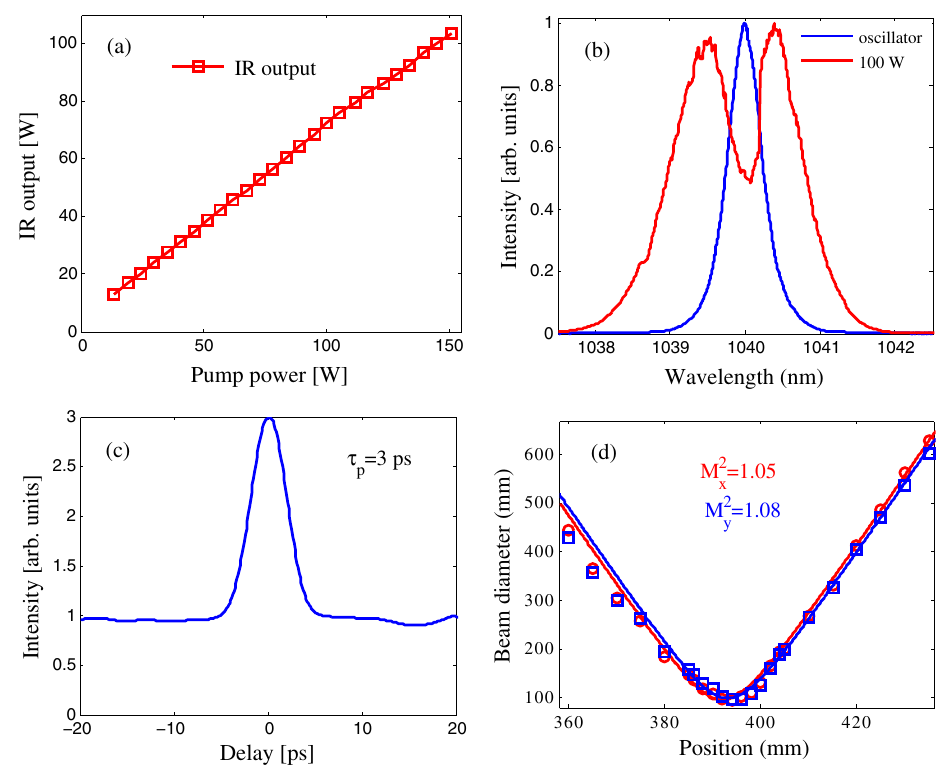
FIG. 7. The characteristics of rod fiber amplifier: (a) IR output versus pump power, (b) optical spectrum of seed light and amplified pulses at 100 W, (d) intensity autocorrelation of 100 W IR output, (e) M 2 values at 100 W IR